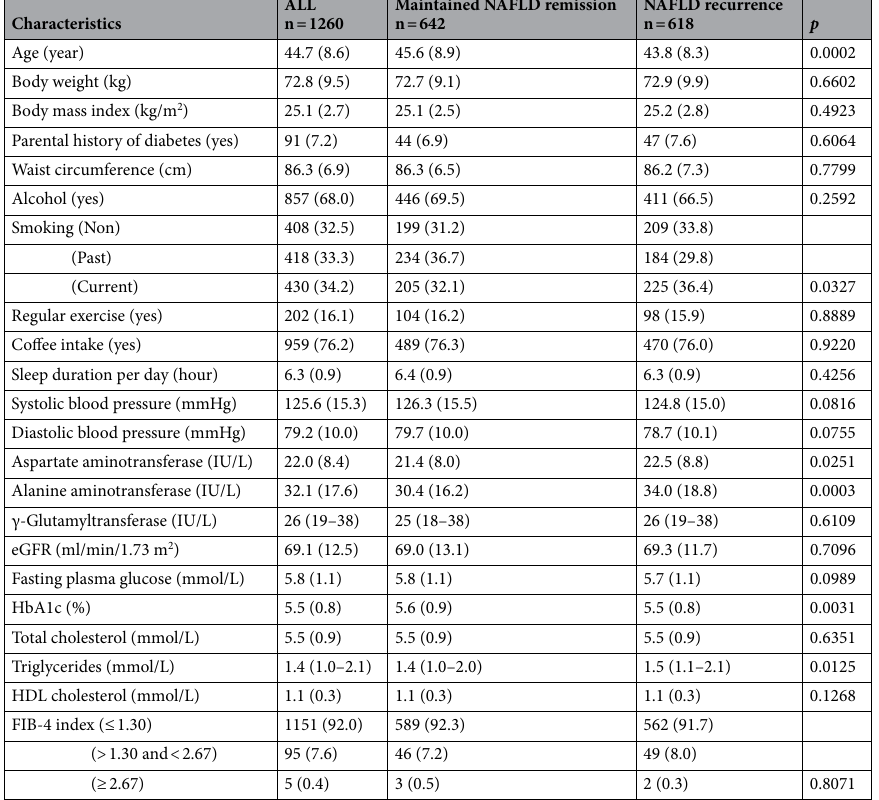
Table 1. Baseline characteristics of male study participants in the whole cohort and each group.